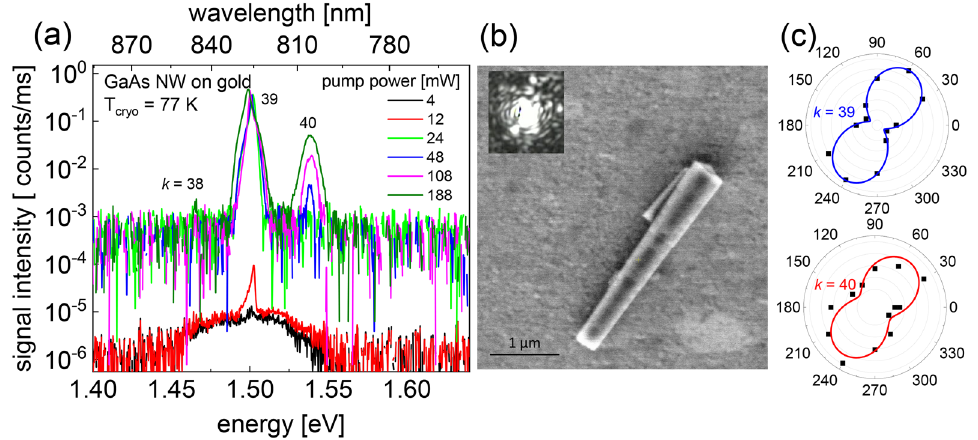
Figure 2. Lasing from a GaAs NW on Au film. ( a ) Pump power dependent lasing spectra of a GaAs NW on Au film at a cryostat temperature of T cryo =77 K and excitation wavelength of λ p = 720 nm. Mode numbers k are indicated. ( b ) SEM image of the NW investigated in ( a ). The inset shows the optical image of the NW emission at 80 mW. Interference fringes indicate coherent lasing emission. ( c ) Polar plots of longitudinal lasing modes k = 39 and